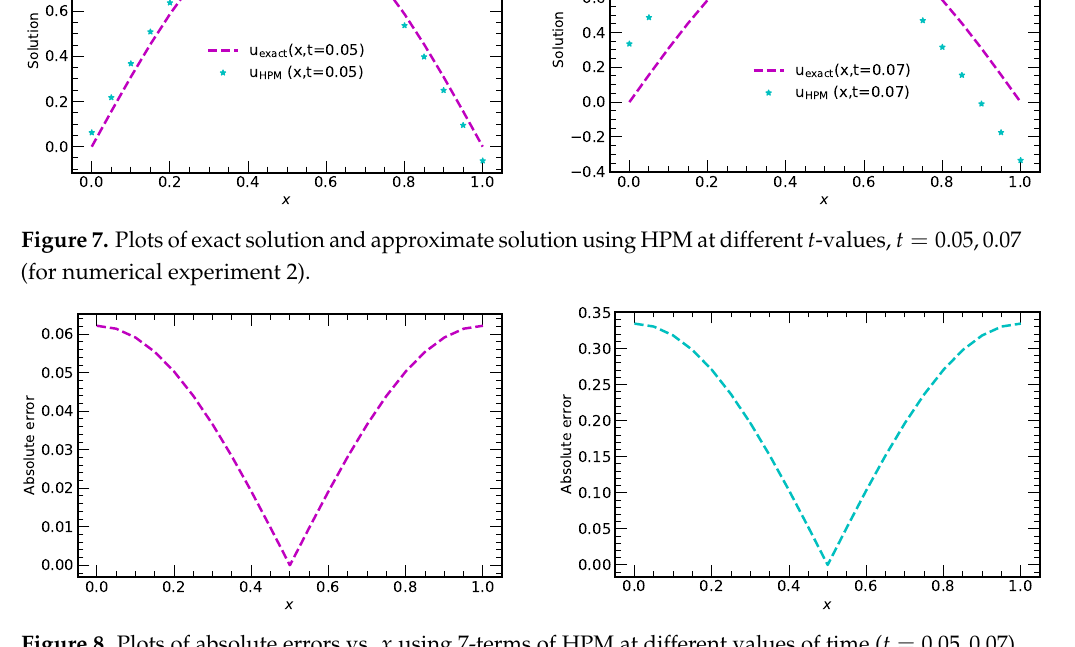
Figure 8. Plots of absolute errors vs. x using 7-terms of HPM at different values of time ( t =